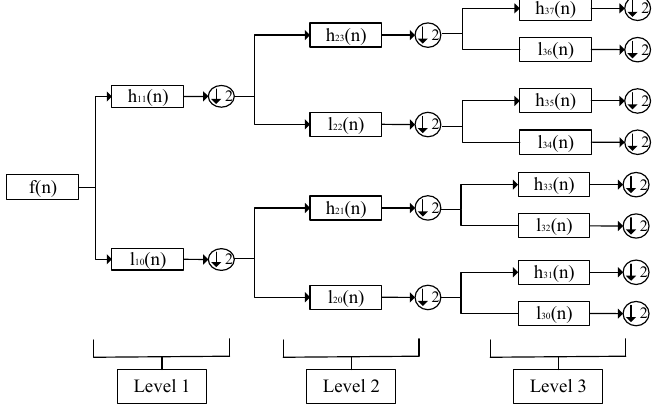
Figure 4. The process of three-level wavelet packet decomposition.